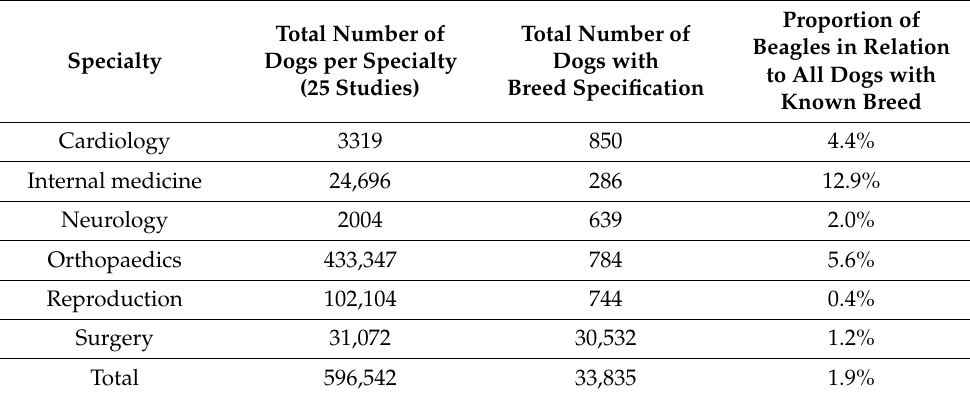
Table 3. Numbers and proportions of Beagle dogs utilized in clinical trials within six veterinary specialties ( n = 150).